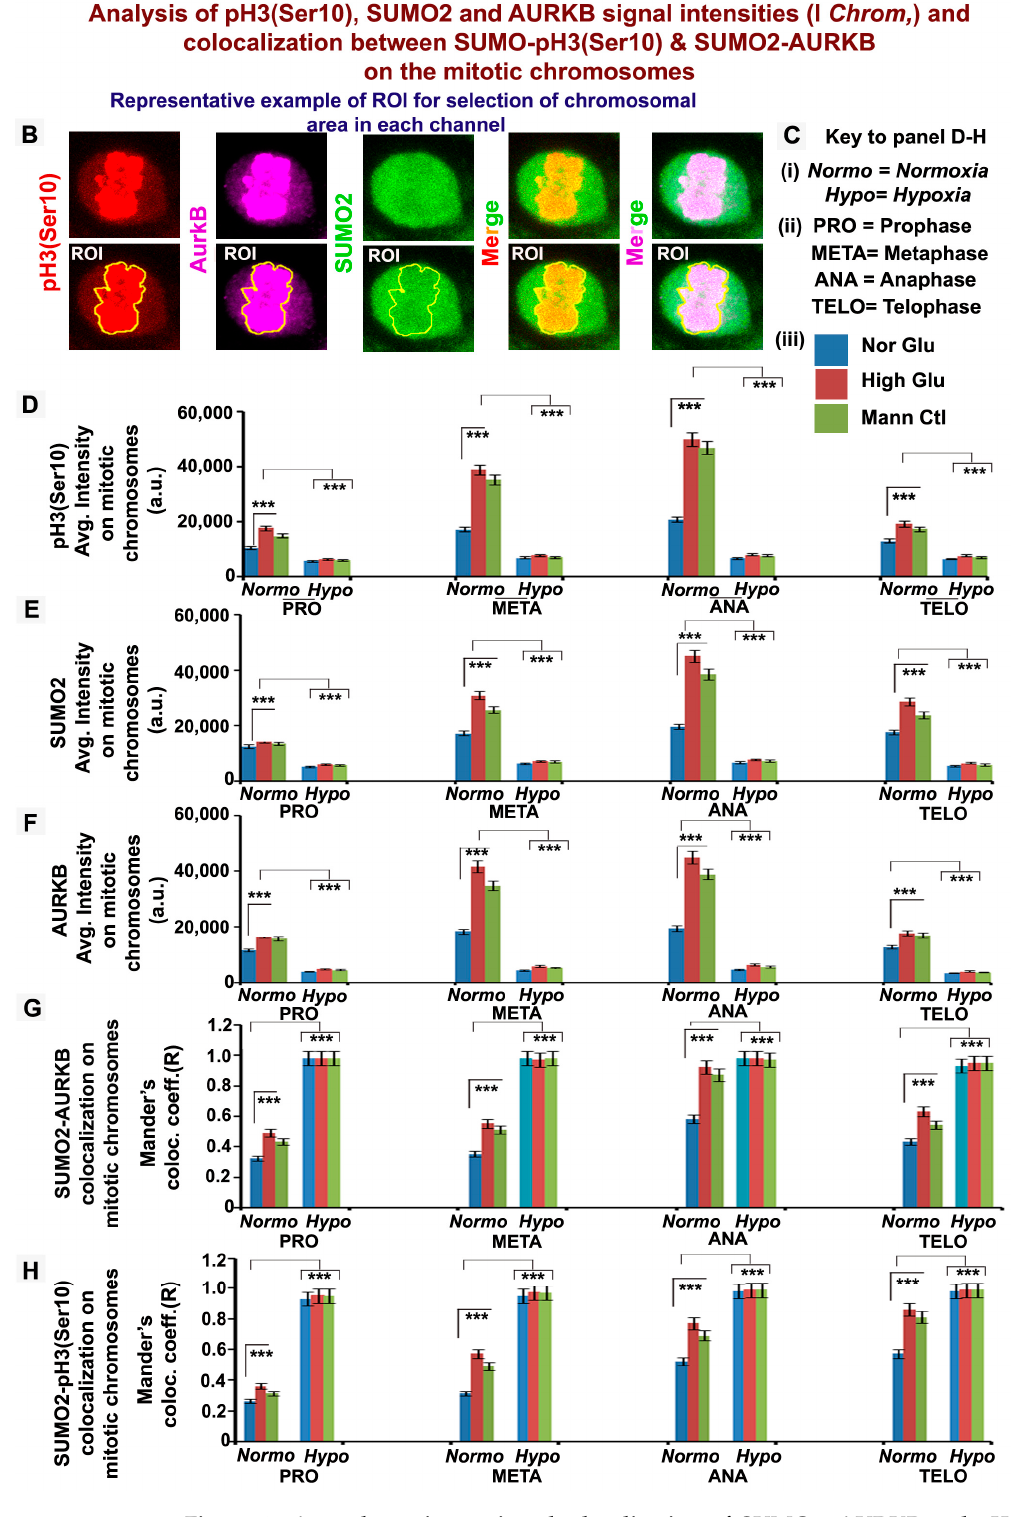
Figure 4. Acute hypoxia restricts the localization of SUMO2, AURKB and pH3(Ser10) on the mitotic chromosomes of the tumour cells. CaSki/C-33A cervical cancer cells were cultured for 96 h in NG, HG and HG-HO, with or without hypoxia stimulation. ( A ) Cells were immunostained with SUMO2, AURKB and pH3(Ser10). Coloured arrows in the middle panel indicate an example of differences in expression between normoxia and hypoxia. ( B ) An example of free-hand ROI